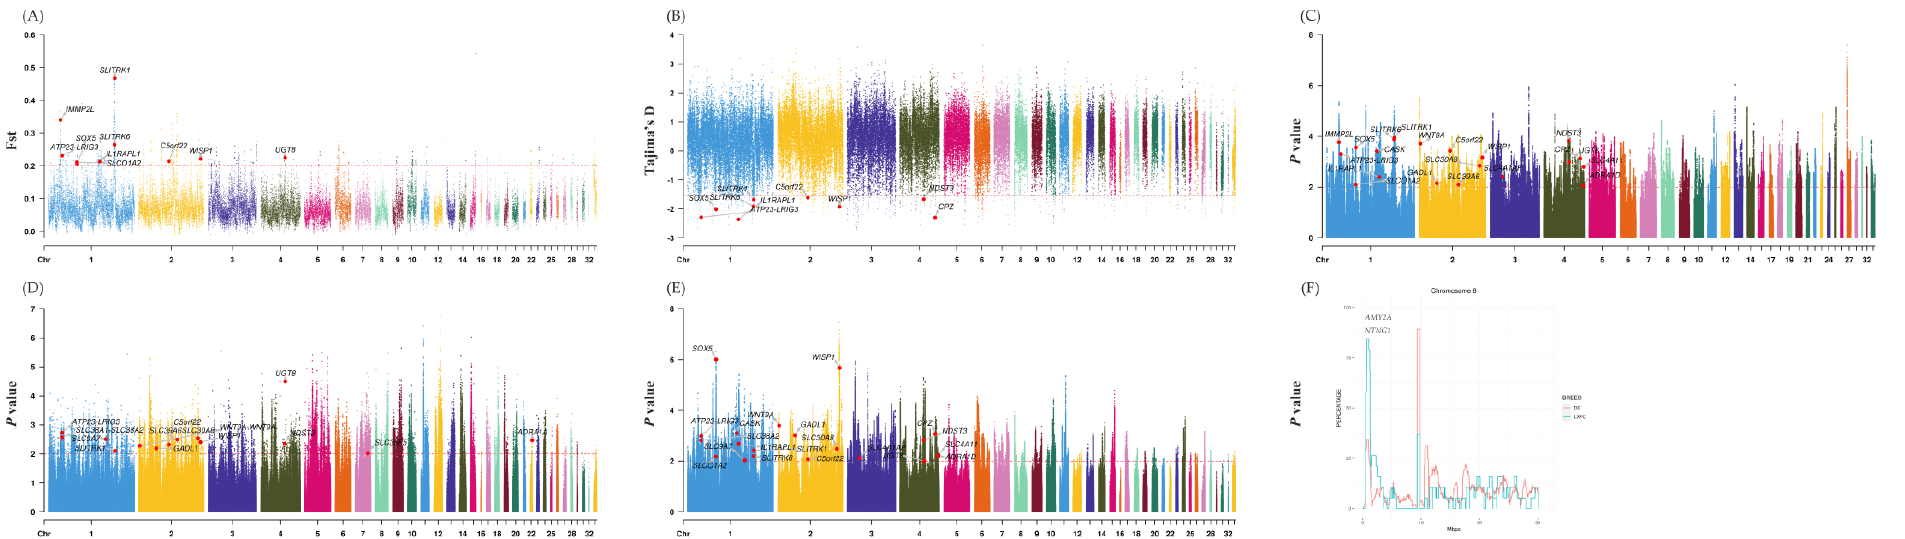
Figure 1. Manhattan plots generated by six selective sweep detection methods. ( A ) Fst values. ( B ) Tajima’s D values. ( C ) experienced distribution p values of hapFLK. ( D ) experienced distribution p values of iHS. ( E ) experienced distribution p values of XP-EHH. ( F ) SNP occurrence percentage on Chr8. DCs refer to domesticated chickens except LXFCs.